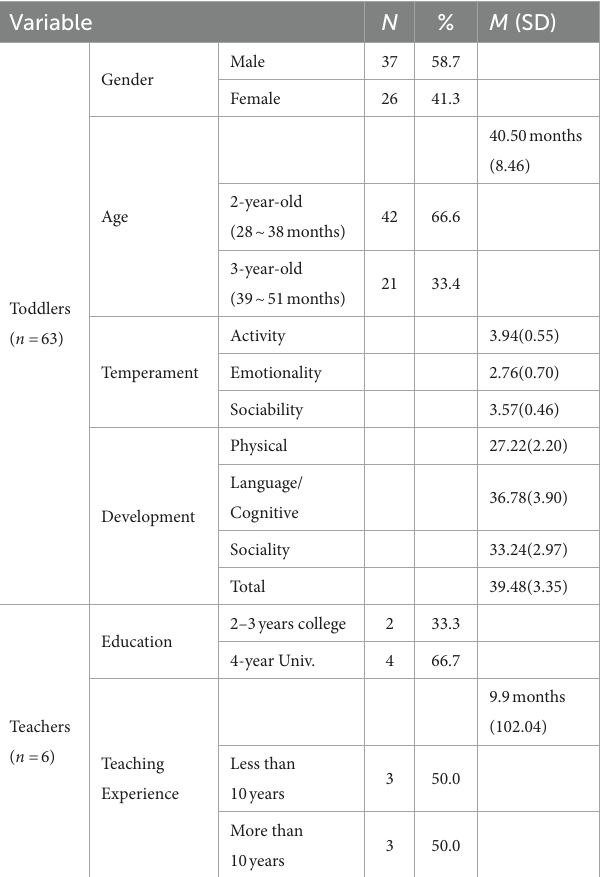
TABLE 1 Descriptive statistics for study